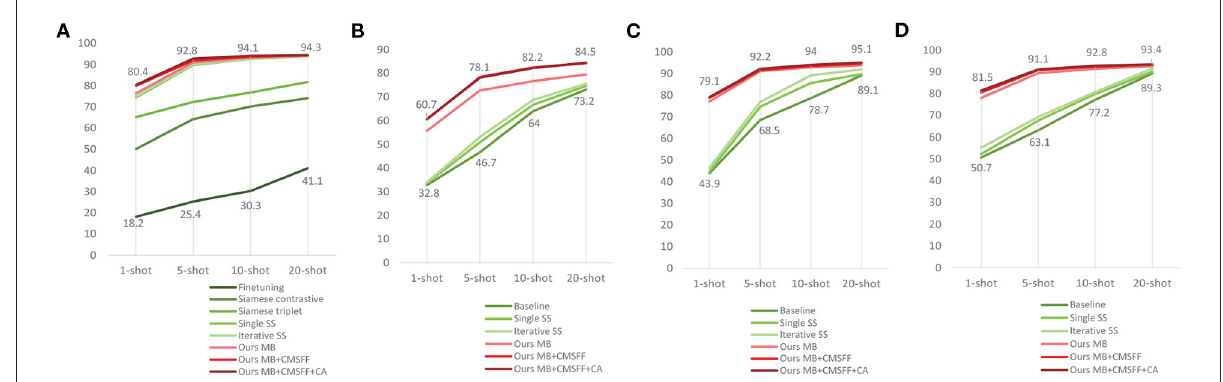
FIGURE7 The results compared with related works. (A) Our work compares with (Argüeso et al., 2020) and (Li and Chao, 2021b). (B) Our work compares with Li and Chao (2021b) using the data split-1. (C) Our work compares with Li and Chao (2021b) using the data split-1. (D) Our work compares with Li and Chao (2021b) using the data